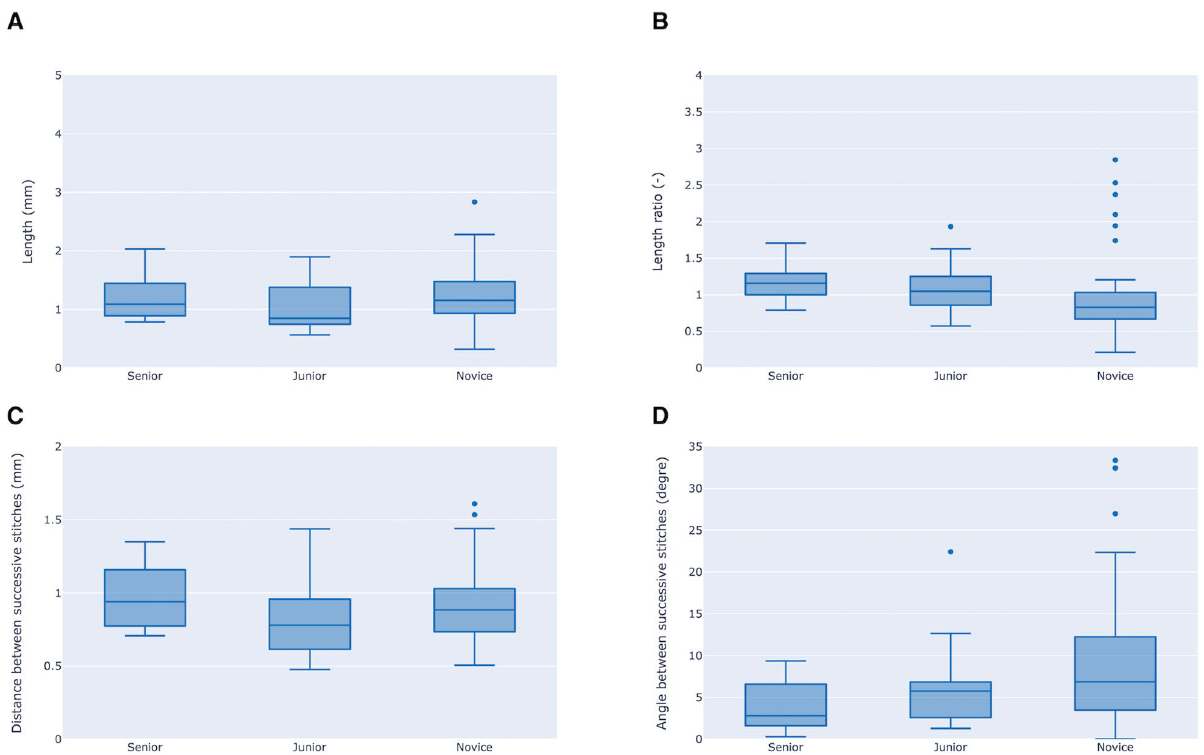
Figure 3. Box-and-whisker representing objective geometric assessments of the corneal stitches for three groups of surgeons. The length of stitches ( A ), the length ratio with respect to the first stitch ( B ), the distance between two successive stitches ( C ) and the angle between two successive stitches ( D ) are depicted. Length ratio with respect to the first stitch significantly increased in more experienced groups (novice group < junior group < expert group; p = 0.011). Data are represented as medians and interquartile